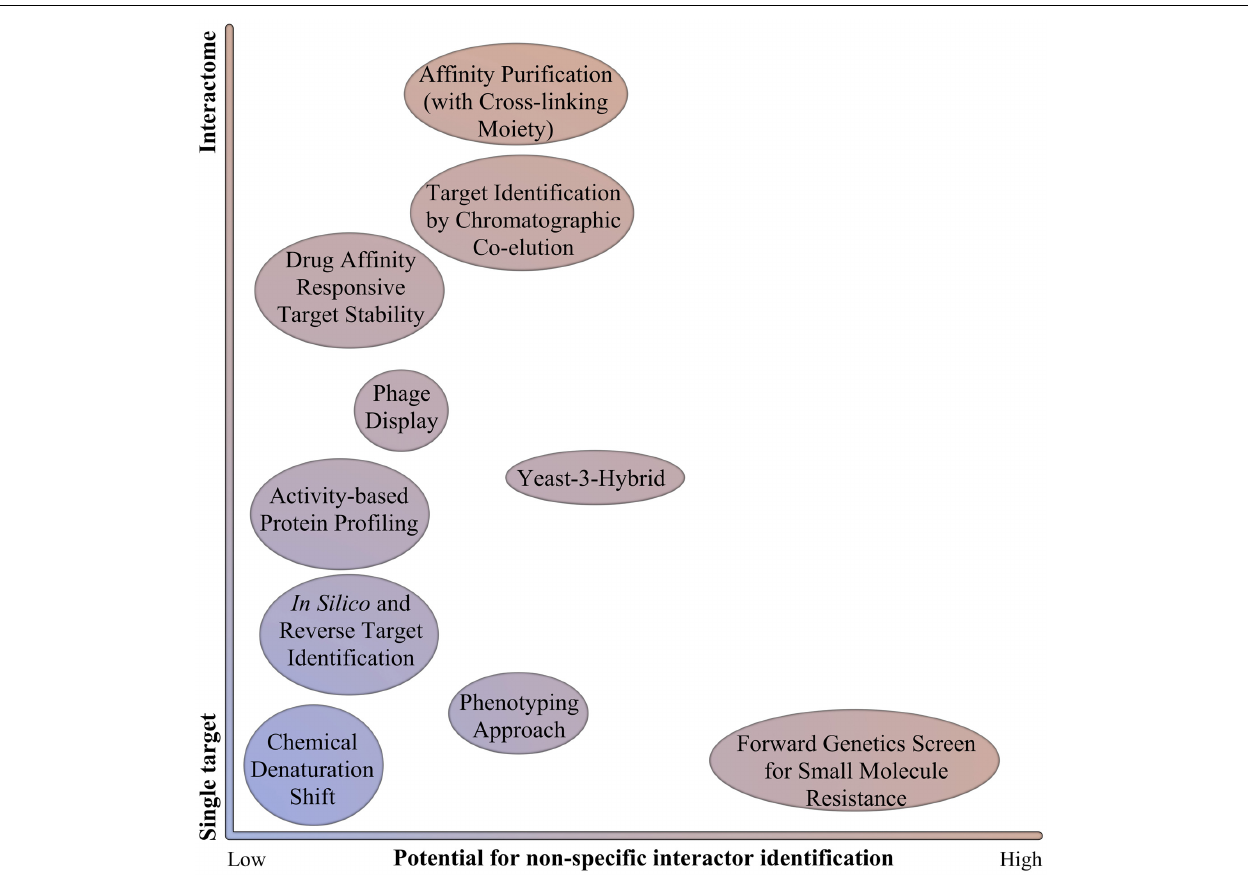
FIGURE 1 | Schematic representation of target identification strategies. Target identification strategies are represented in function of their ability to identify only one target or several targets (interactome), and the potential to